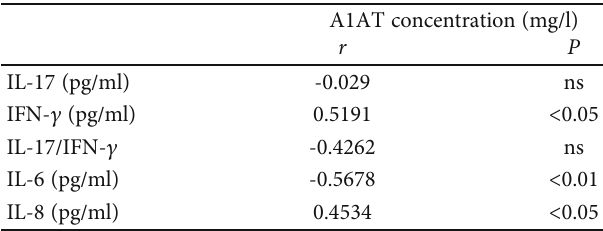
Table 2: Correlation analysis between A1AT concentrations and proin fl ammatory cytokine levels in patients with